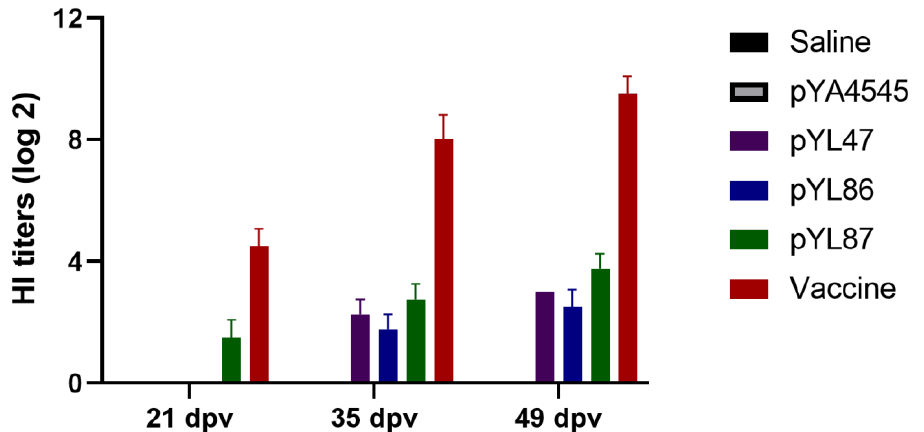
Figure 3. The haemagglutination inhibition (HI) antibody titers were determined at days 21, 35, and 49 postvaccination (dpv).The results are shown as means ± SEM ( n = 3).